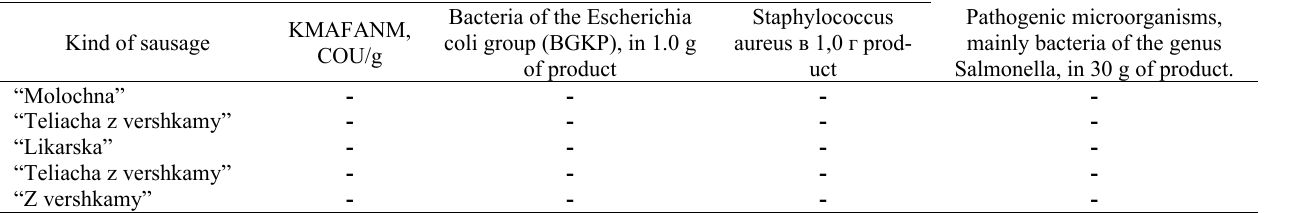
Microbiological indicators of cooked sausages Kind of